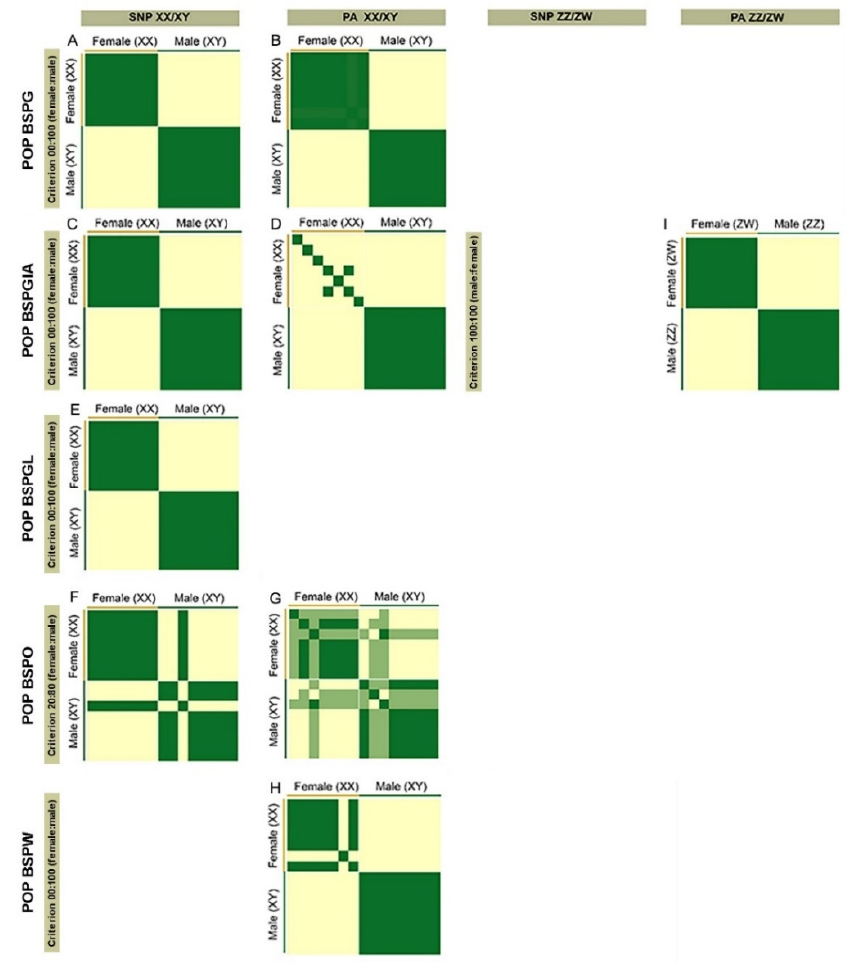
Figure 2. Hamming distances of male and female Siamese fighting fish ( Betta splendens Regan, 1910) [1] using single-nucleotide polymorphism (SNP) and presence-absence (PA) loci. ( A ) SNP loci filtered with the criterion of 0:100 (females:males) (POP_BSPG), ( B ) PA loci filtered for 0:100 (females:males) (POP_BSPG), ( C ) SNP loci filtered with the criterion of 0:100 (females:males) (POP_BSPGIA), ( D ) PA loci filtered for 0:100 (females:males) (POP_BSPGIA), ( E ) SNP loci filtered with the criterion of 0:100 (females:males) (POP_BSPL), ( F ) SNP loci filtered for 20:80 (females:males) (POP_BSPO), ( G ) PA loci filtered for 20:80 (females:males) (POP_BSPO), and ( H ) PA loci filtered for 0:100 (females:males) (POP_BSPW) for the XX/XY system, ( I ) PA loci filtered for 100:0 (females:males) (POP_BSPGIA for the ZZ/ZW